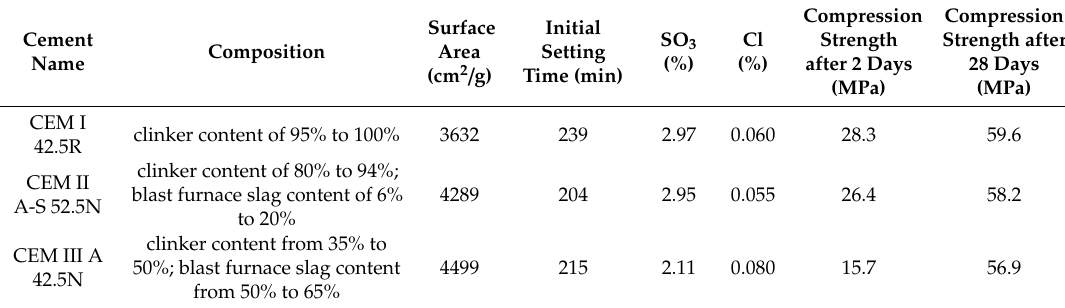
Table 1. Characteristics of cements.